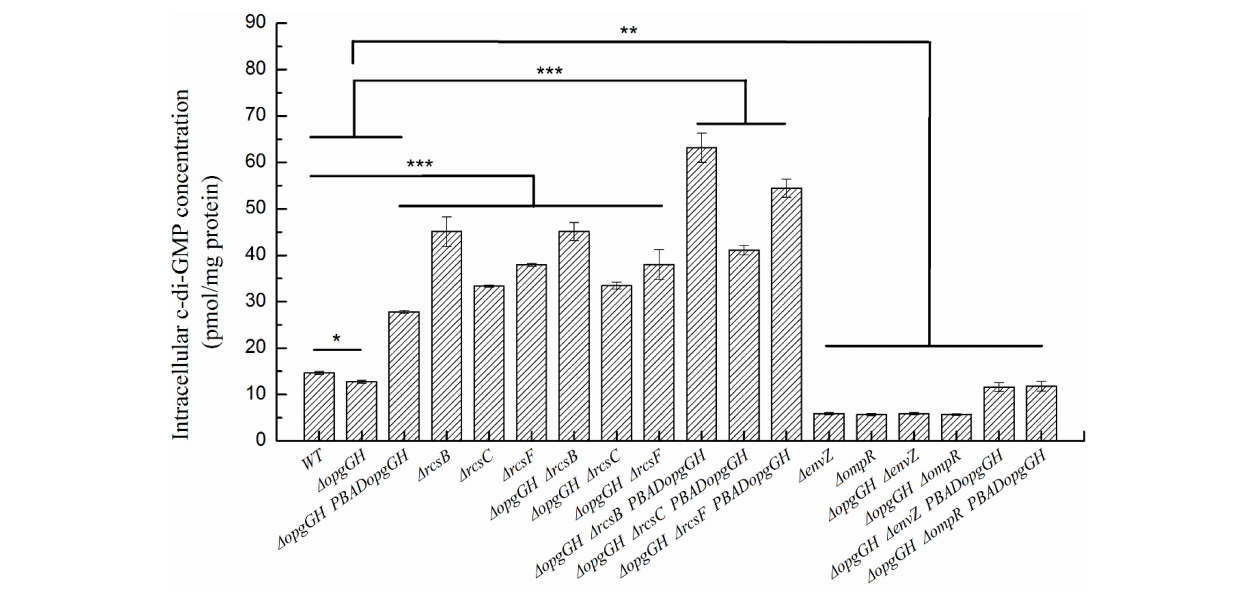
FIGURE 5 | The intracellular c-di-GMP concentration in wild-type and mutant strains of Y. enterocolitica . Bacteria were cultured in LNNS medium supplemented with 0.6 g/L L -arabinose at 26 ◦ C. Intracellular c-di-GMP levels were analyzed in bacteria grown to the exponential phase. The data are presented as the mean ± SD of at least three independent experiments. An asterisk indicates a significant difference with *** P < 0.001, ** P < 0.01, * P < 0.05.